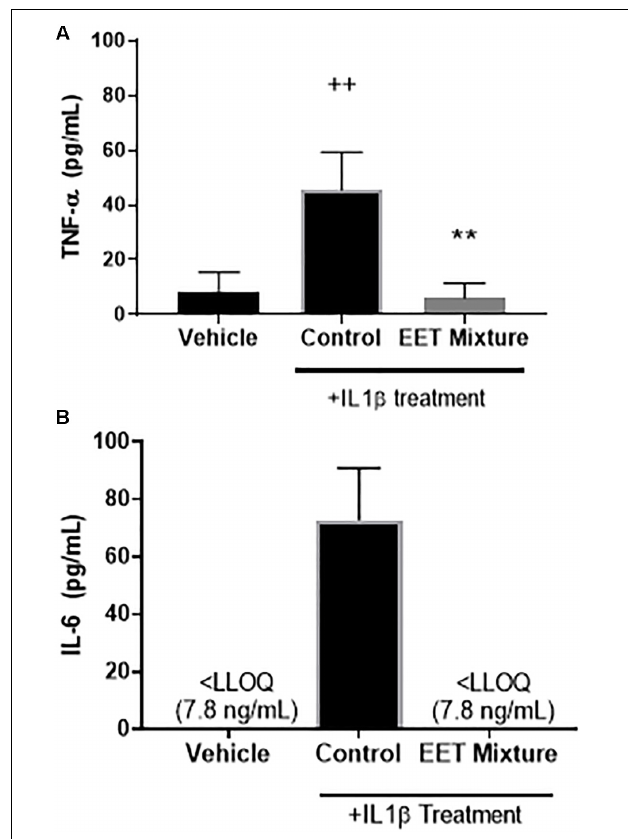
FIGURE 5 | EET mixture (0.4 µ g/mL) significantly reduced inflammatory cytokines, TNF- α and IL-6 after a 2-h treatment of IL1 β (10 ng/mL). Inflammatory cytokines, TNF- α (A) and IL-6 (B) , protein levels were measured by ELISA 48-h after a 2-h treatment of IL1 β or vehicle. Treatment with IL1 β significantly increased both cytokines. When a mixture of EET regioisomers (0.1 µ g/mL of each for a total of 0.4 µ g/mL total) was added to the media after IL1 β was removed, IL-6 and TNF- α decreased to levels comparable to cells not treated with IL1 β . p < 0.005 between IL1 β treated and not-treated (++) and post IL1 β treated vehicle vs. EET ( ∗∗ ). There was no significant difference between cells not treated with IL1 β and cells treated with EET mixture after a 2-h after IL1 β